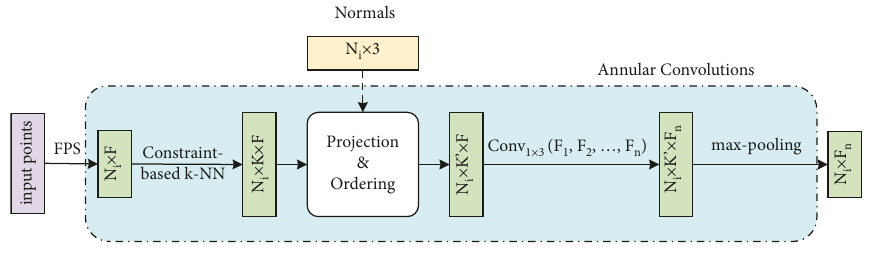
Figure 1: A-CNN abstract layer